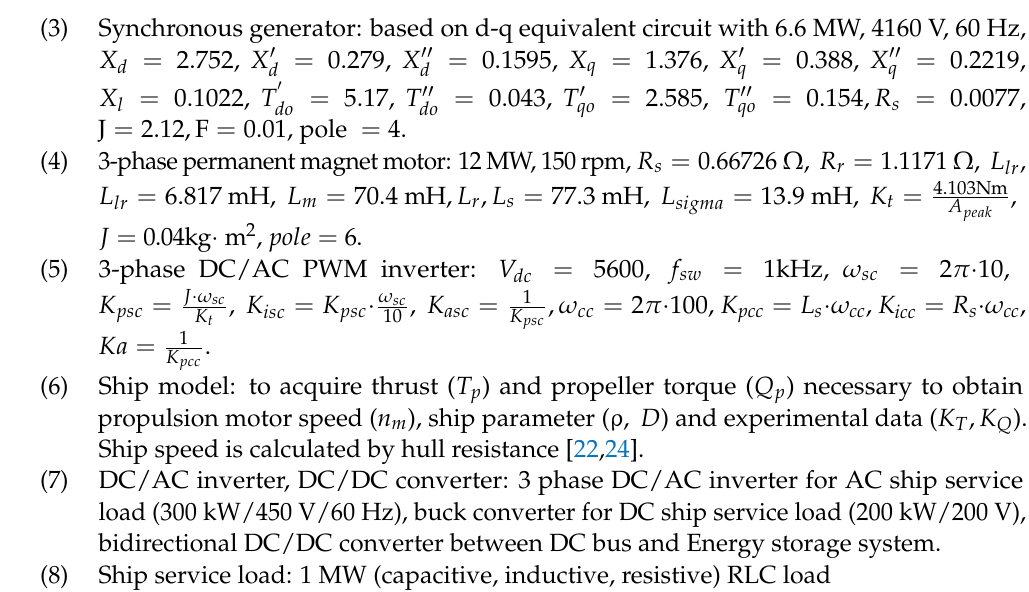
Figure A3. Configuration of the IEEE type DC1A excitation model.